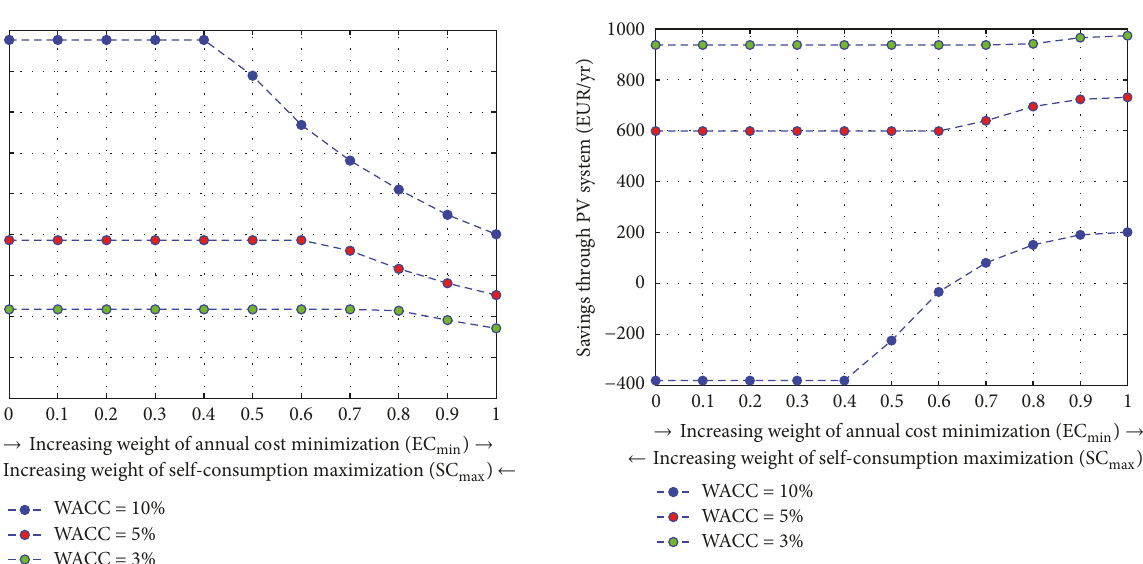
Figure 23: German retail electricity prices: revenues for property owners for different WACCs.